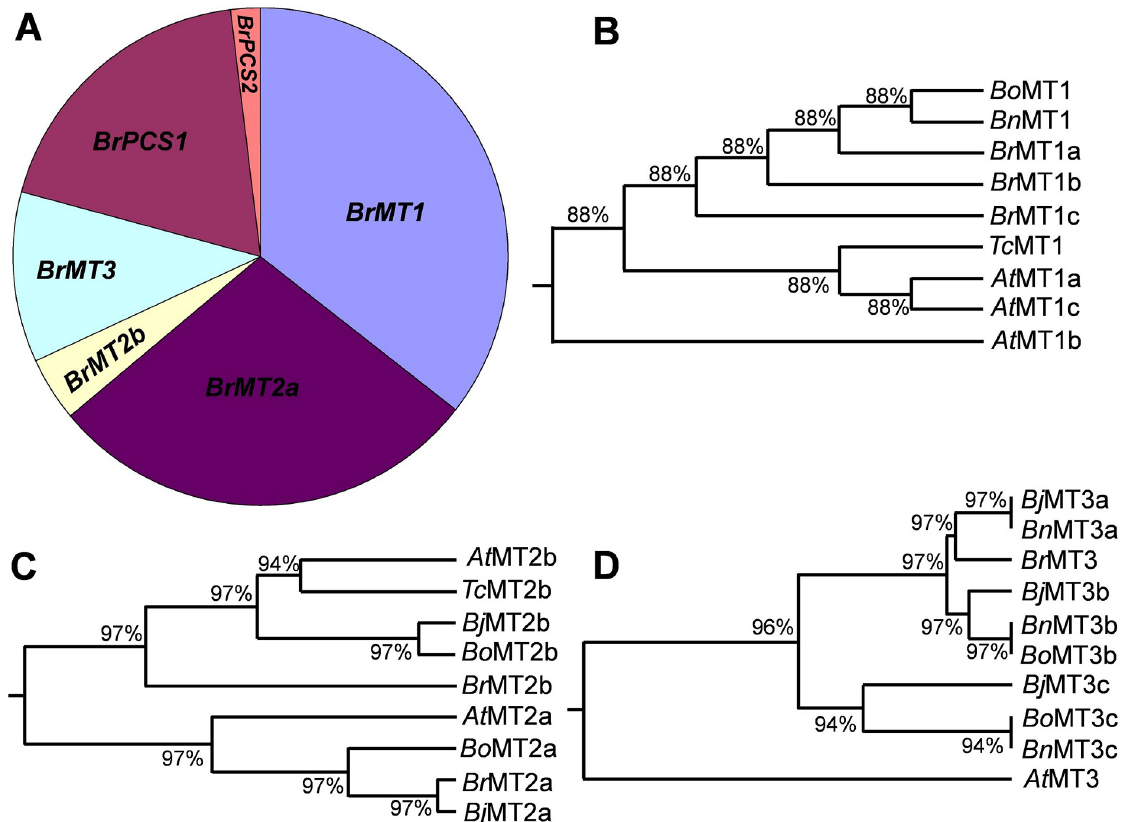
Fig 2. Relative frequency of Cd tolerance genes and phylogenetic trees of BrMTs in Brassica family. (A) Relative frequency of Cd tolerance genes in B . rapa . Cd tolerance genes were identified from 200 yeast clones exhibiting Cd tolerance, and the relative frequency of Cd tolerance genes was analyzed. (B-D) Phylogenetic analysis using the neighbor-joining method implemented in MEGA X. The results are based on multiple alignments of MTs amino acid sequences. The bootstrap values (percentage) of 1000 replicates are shown at the branching